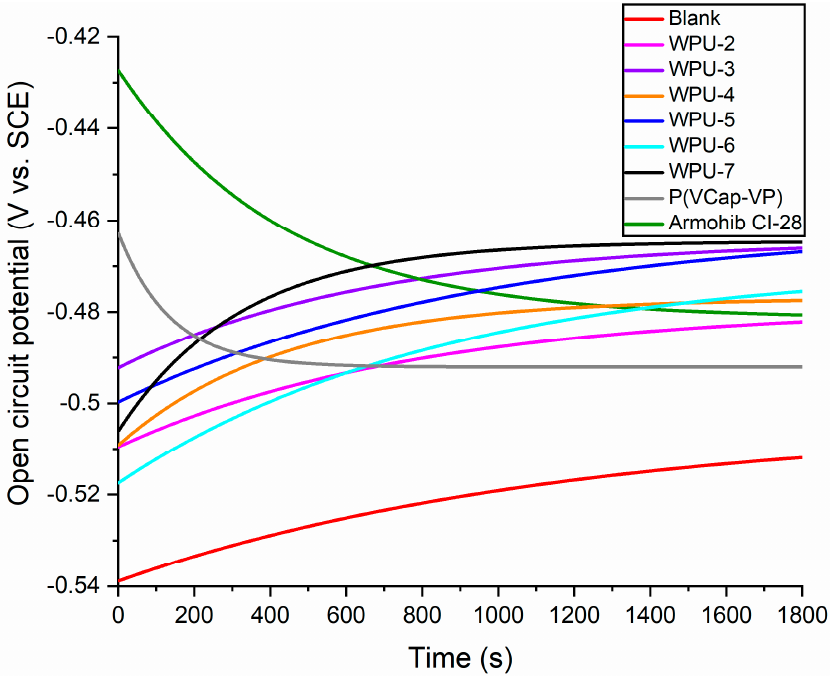
Figure 6. Variation of open circuit potential with time for CS in 2M HCl solution without and with inhibitors (500 ppm); SCE—silver chloride electrode. inhibitors (500 ppm); SCE—silver chloride